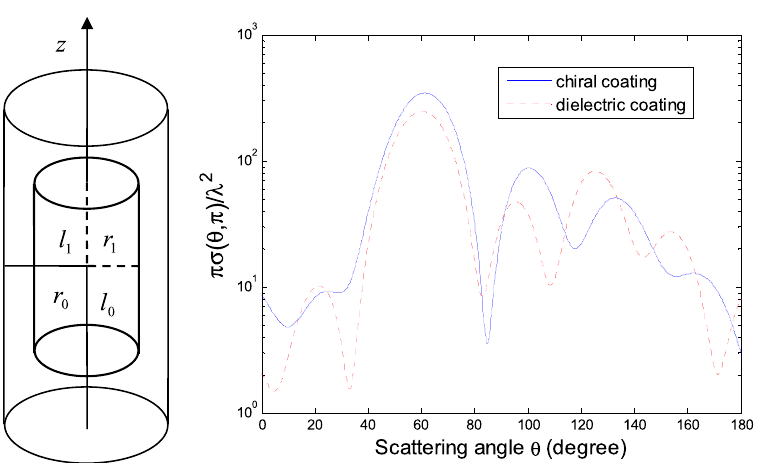
= 2 λ , α = β = 0, x = y = z = 0). 0 0 0 0